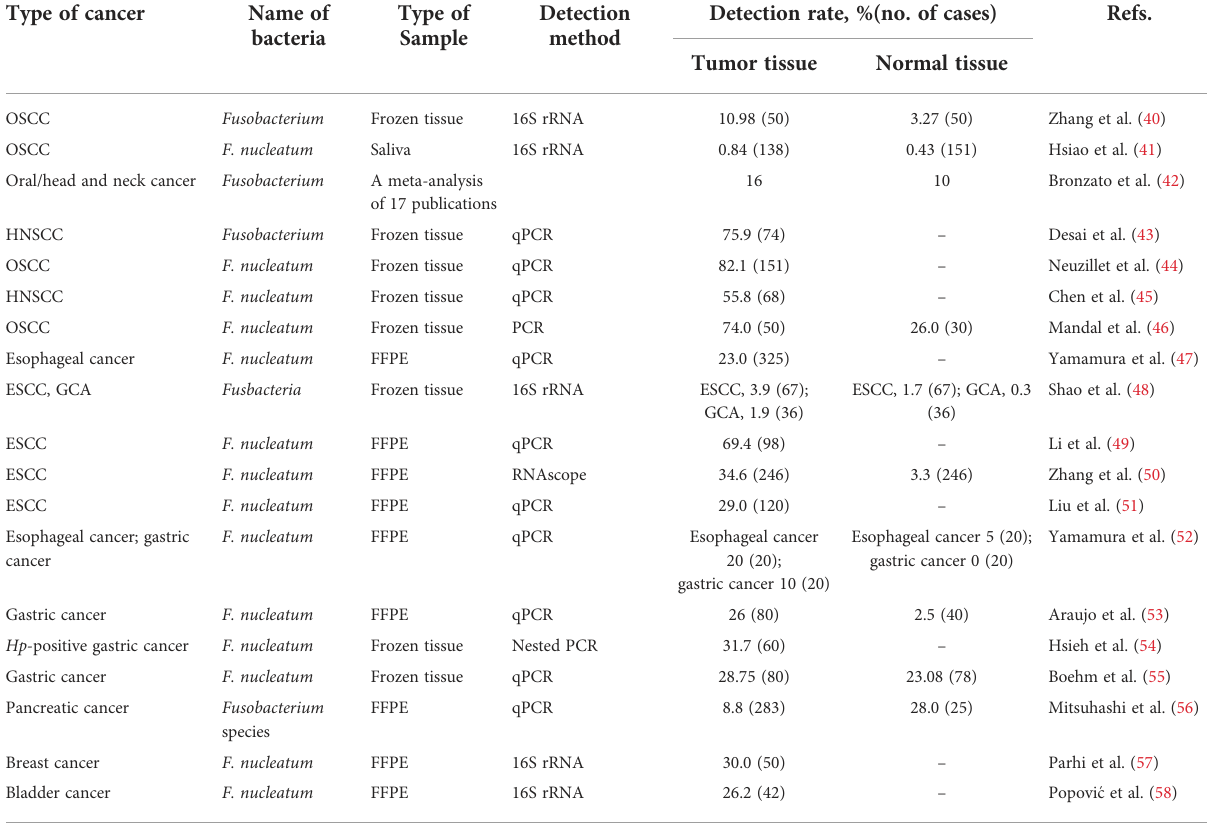
TABLE 1 Detection rates of Fusobacterium spp. in malignancies except for colorectal cancer from previous